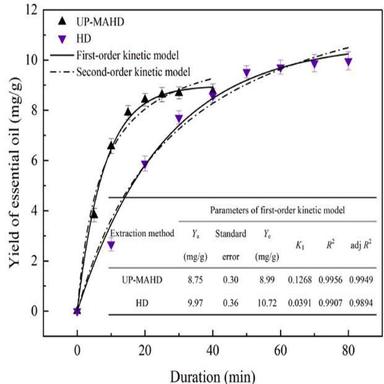
Dynamic curve of the essential oil yield (Note: a Actual yield (%); b Predicted yield (%)).